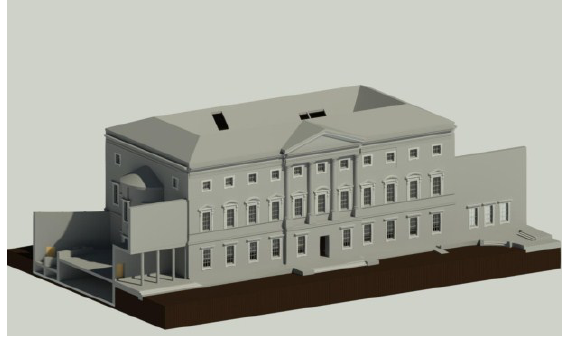
Figure 10: HBIM model imported into Unity Game Engine